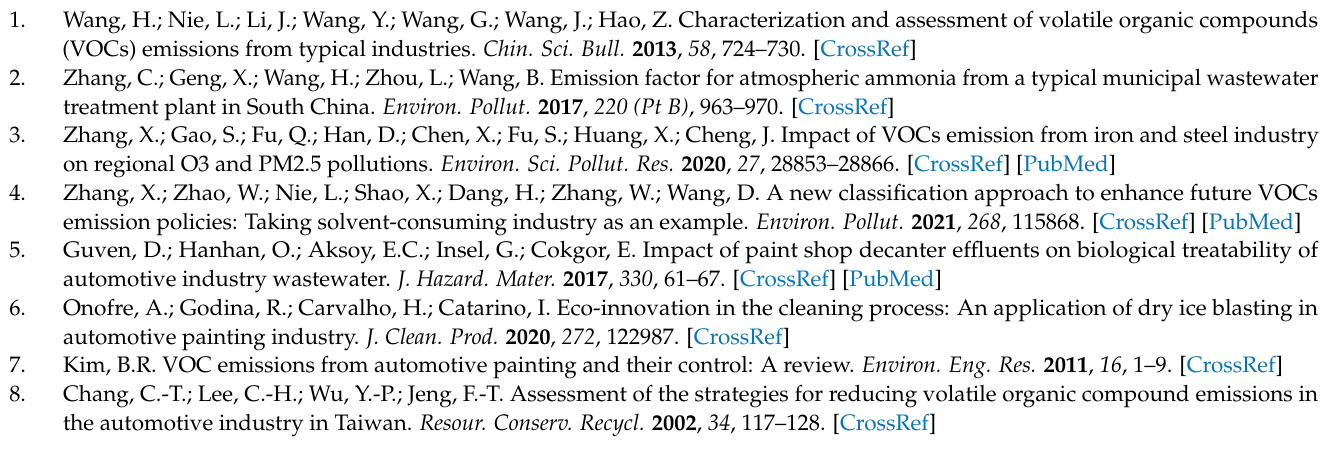
tem. Figure S1: Peak concentration of each target chemical at maximum ground-level concentration (MGLC) after modification for Scenario 1–3; Figure S2: Peak concentration of each target chemical at maximum ground-level concentration (MGLC) after modification for Scenario 4–6; Figure S3: Peak concentration of each target chemical at maximum ground-level concentration (MGLC) after modification for Scenario 7–11; Figure S4: Peak concentration of each target chemical at maximum ground-level concentration (MGLC) after modification for Scenario 12–16; Figure S5: Peak concentra- tion of each target chemical at maximum ground-level concentration (MGLC) after modification for Scenario